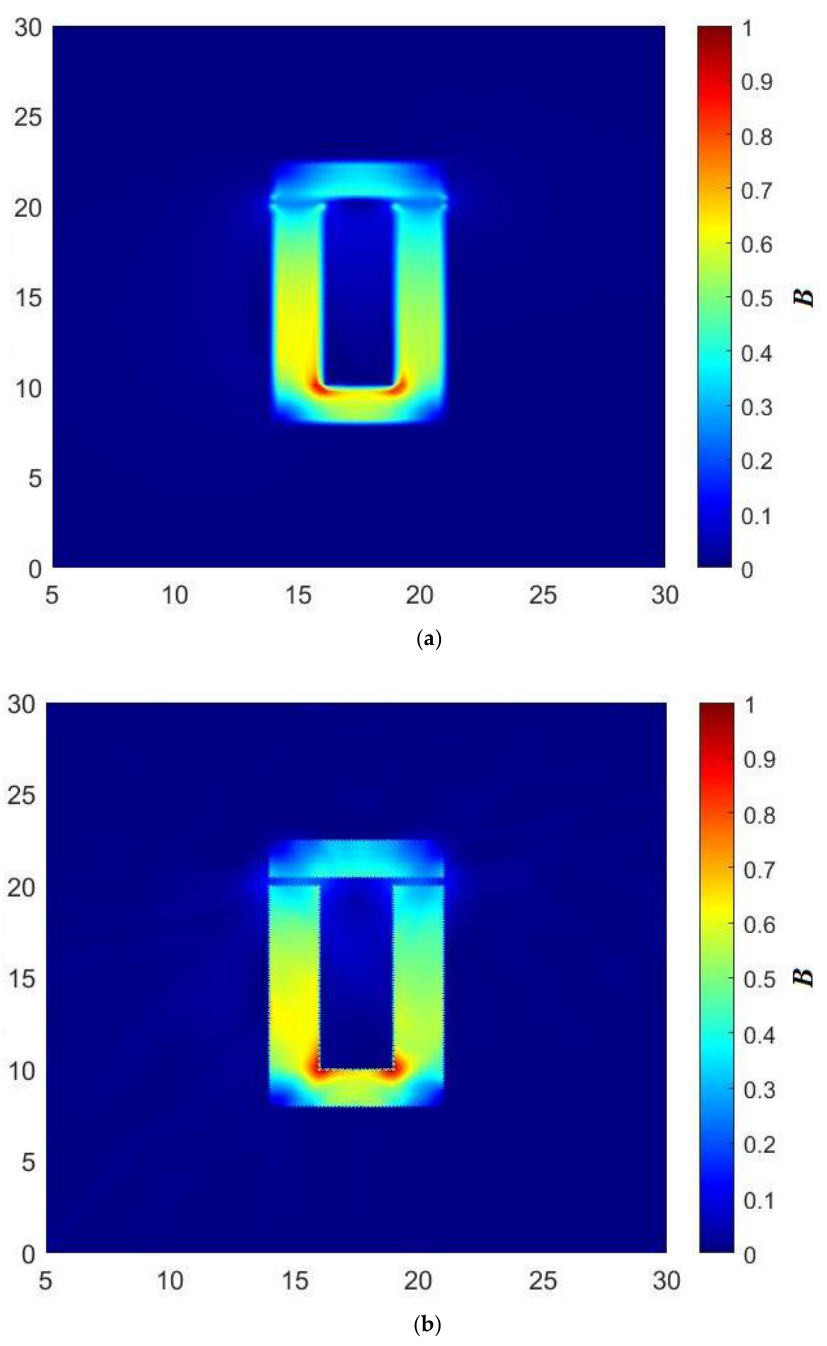
Figure 10. Comparison of cloud images of ui-shaped inductor: ( a ) the finite element calculation result and ( b ) the neural network prediction result.